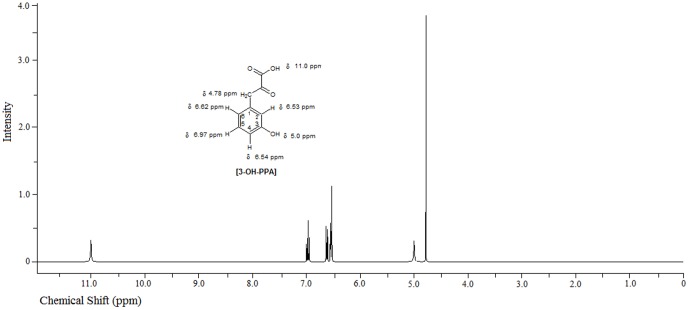

1H-NMR analysis of the 3-hydroxyphenylpyruvate (3-OH-PPA) intermediate indentified during the degradation of m-tyrosine by resting cells of Bacillus aquimaris SSC5.